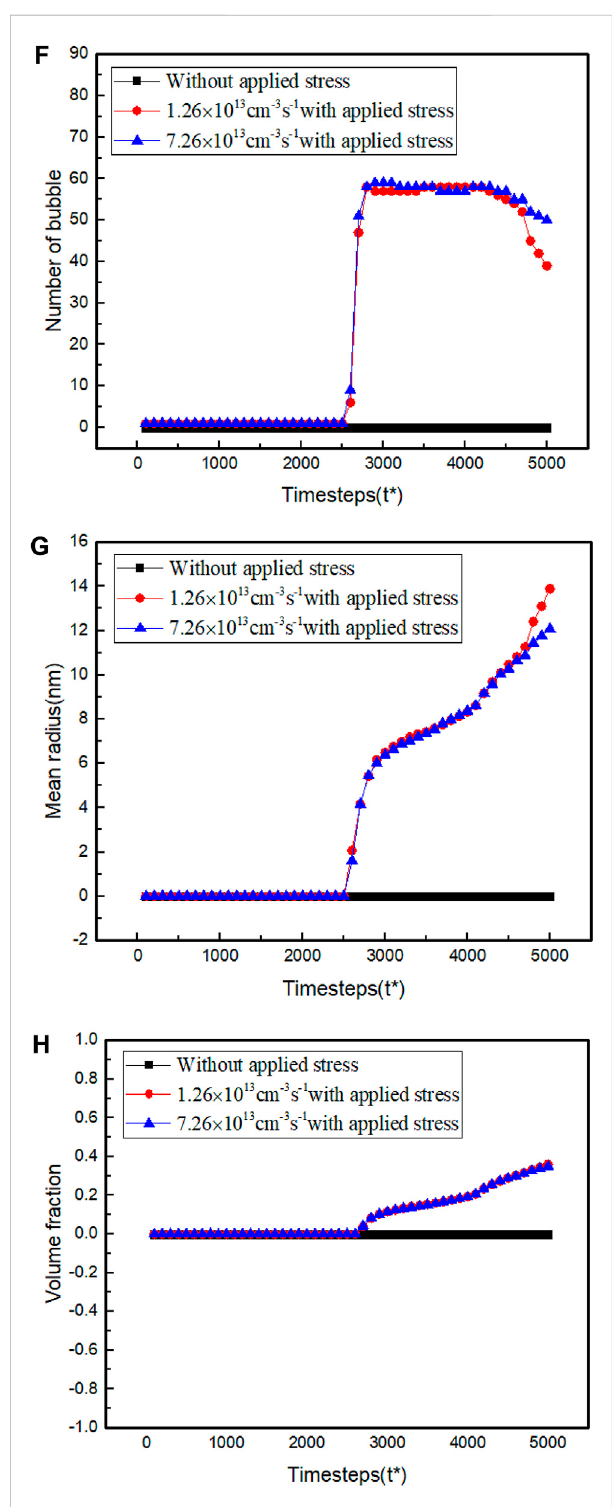
Comparison of the (F) number, (G) mean radius, and (H) volume fraction of Xe bubbles at 1.26×10 13 cm -3 s -1 and 7.26×10 13 cm -3 s -1